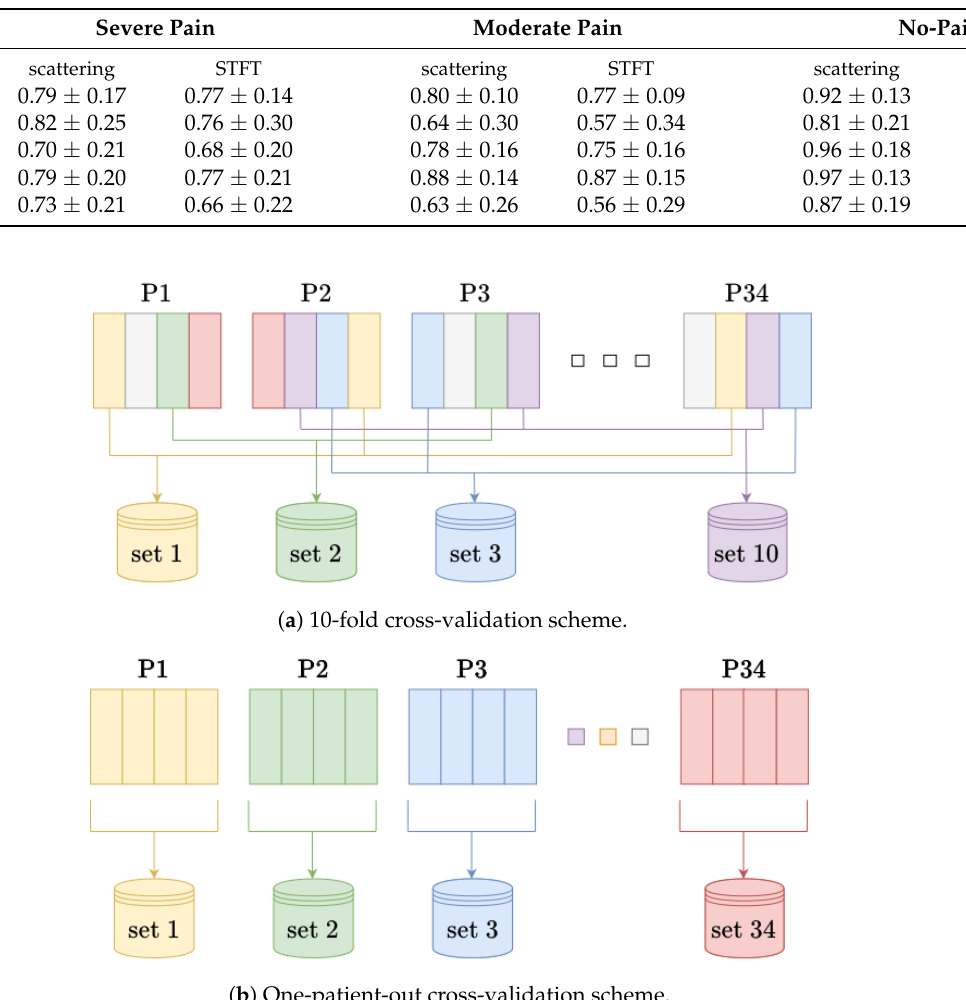
Figure 6. Illustration of cross-validation schemes. In ( a ) frames for test and train sets are selected randomly, whereas data from a single patient could be included in both. Otherwise, for ( b ) data from a single patient stand for the test set and the others for the training set. In both ( a ) and ( b ) the numerical balance throughout the classes is